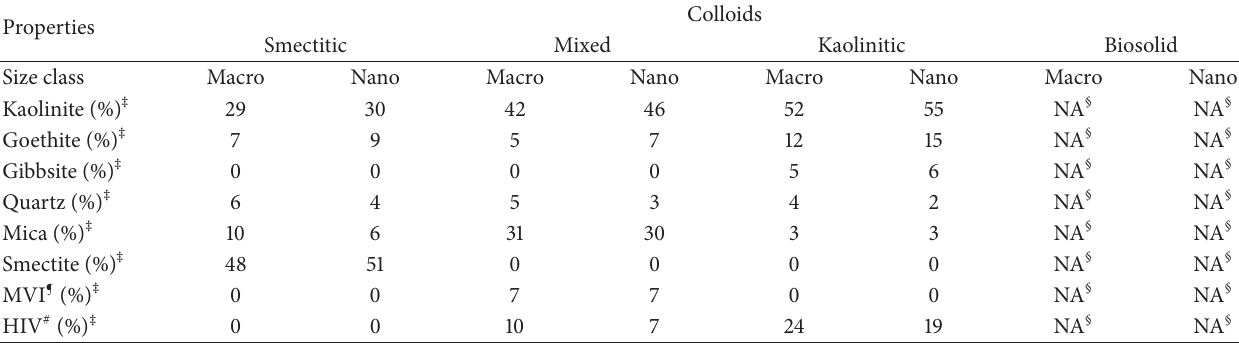
Table 2: Mineralogical compositions of nano- and